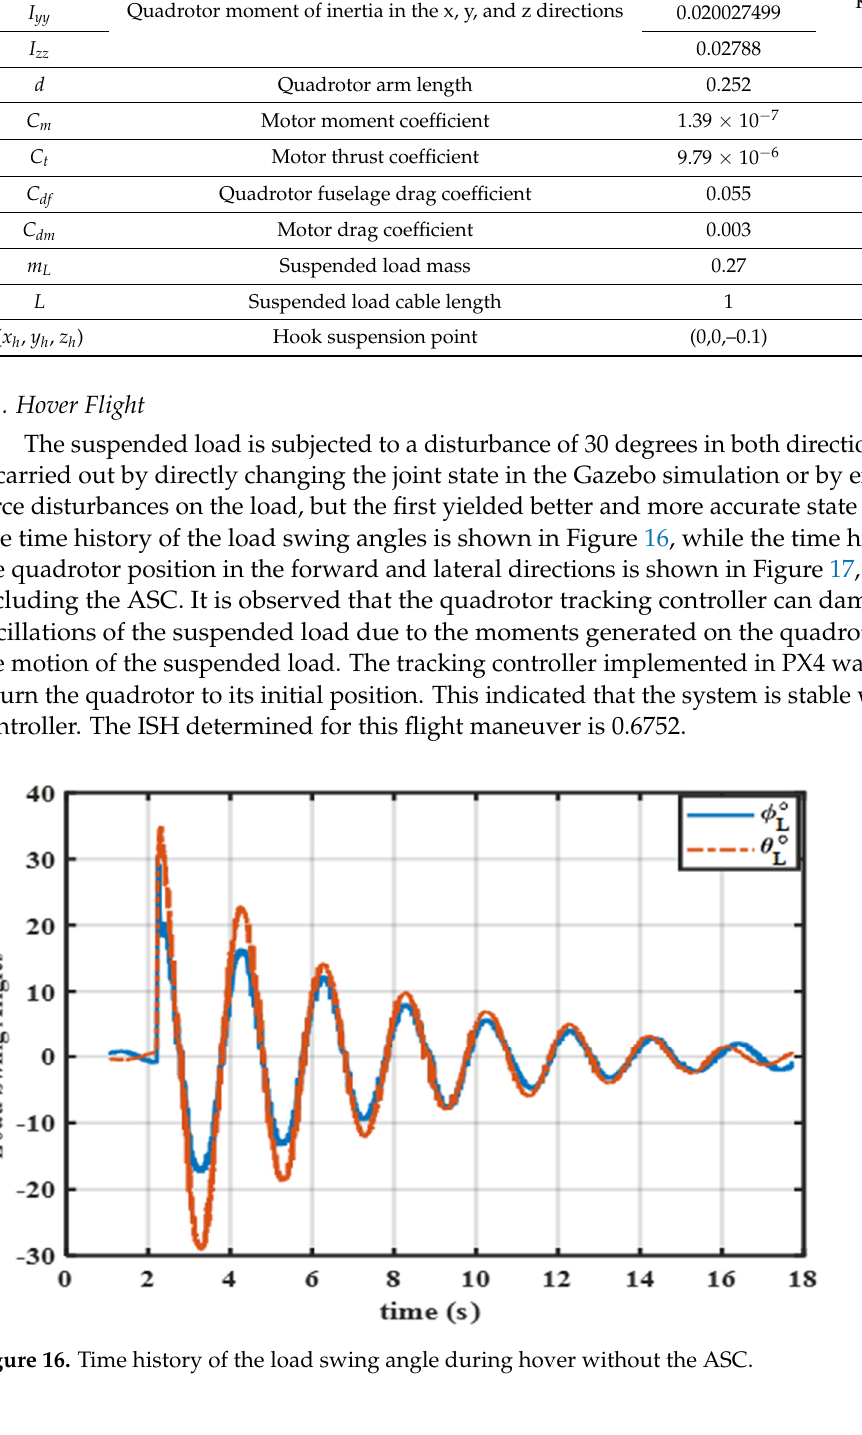
Figure 17. Time history of the quadrotor position during hover without the ASC.